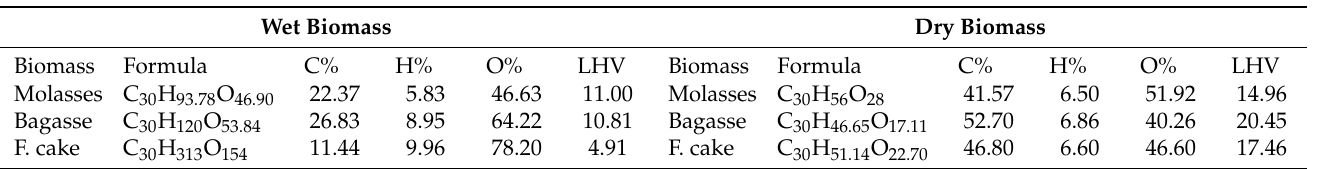
Table 2. Biomass composition and its estimated LHV in wet and dry basis used for the study (using Equation